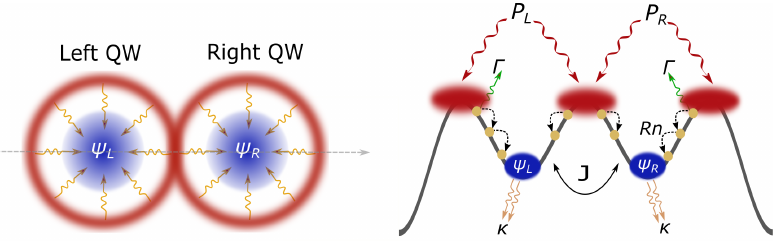
Figure 1. Schematic top view ( left panel ) and side energy view ( right panel ) of a polariton system in a double quantum well. Spatially shaped pumping lasers populate with rates P L and P R the reservoir excitons n L , R , which decay via recombination with rates Γ and energy-relax and scatter into the polariton condensate with rate R . The pumping lasers also create the confining potentials for the polaritons ψ L and ψ R , which decay with rates κ , and are continuously replenished by reservoir excitons with rates Rn L , R , while interacting with each other via the Josephson coupling J